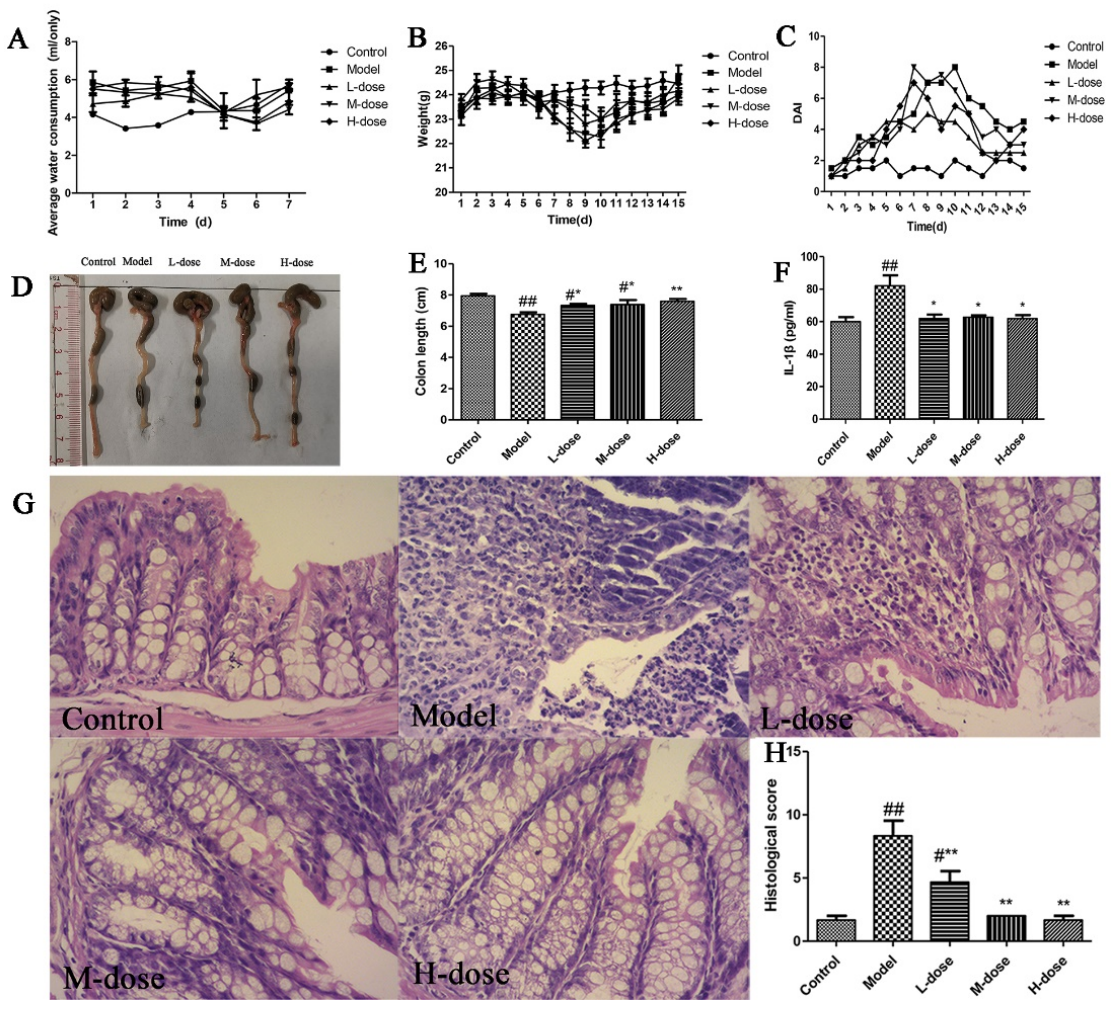
Figure 1. Forsythia suspensa extract alleviates the symptoms of UC in mice. ( A ) Average water consumption during modelling. ( B ) Average weight of the mice ( n = 10). ( C ) DAI score. ( D ) Representative pictures of the colon. ( E ) Average colon length ( n = 10). ( F ) Measurement of the level of IL-1 β in the serum with an ELISA kit. ( G ) Pathological examination of mouse colon tissue (×200). ( H ) Histological score of the colon. Data represent at least three independent experiments. The results are shown as the mean ± SEM. # p < 0.05, and ## p < 0.01 compared with the control group; * p < 0.05, and ** p < 0.01 compared with the model group; #** means # and **.